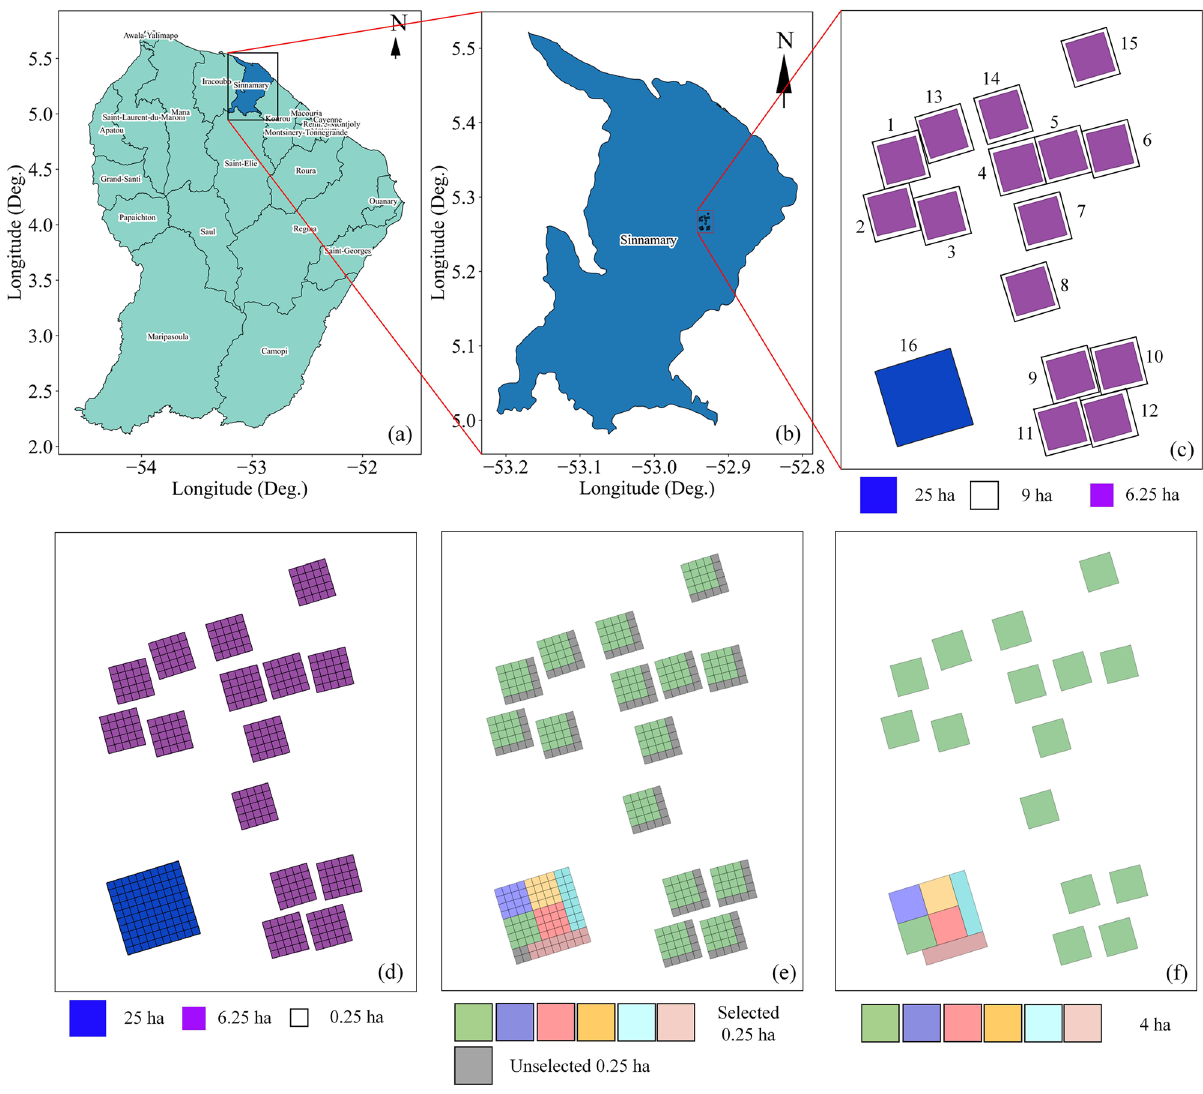
Figure 1. The locations of the Paracou test sites, French Guiana. ( a , b ) are based on the shapefiles from OCHA Field Information Services Section (FISS) 53 , and ( c , d ) are generated from the shapefiles discussed in Labriere et al. 54 and the dataset can be obtained from 55 ( e ) 0.25-ha plots selected for 4-ha plot generation ( f ) generated 4-ha plots. This Figure is generated using python 3.7.4. 56